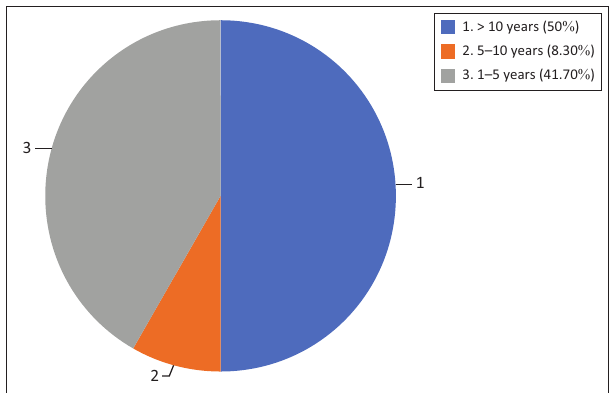
FIGURE 2: Participants’ years of